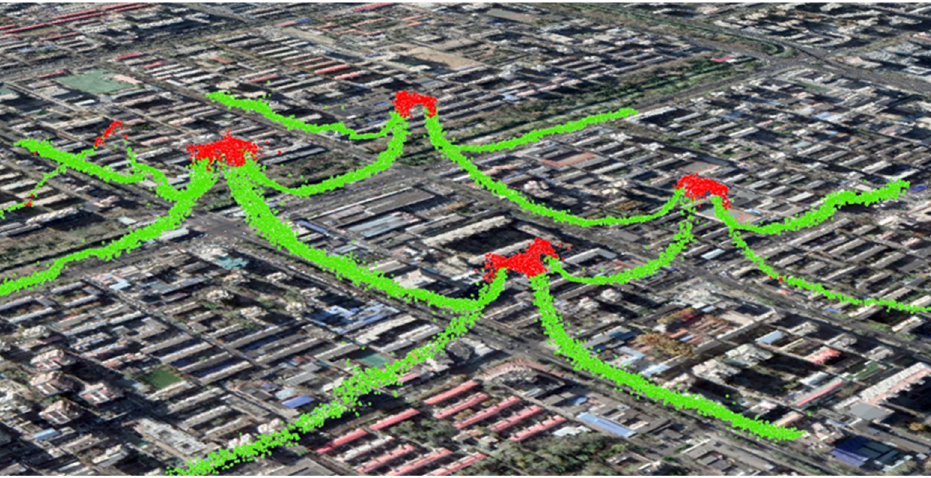
Figure 8. Three-dimensional map of the information entropy values for the tracking points in the Mudanyuan area, where red represents the on-crossroad points and green is the on-road points. We interactively selected 11,368 sample tracking points at the inner side of the Second Ring Road of Beijing, among which 8556 are on the streets and 2812 are at intersections. Based on Equation (1), the information entropies were computed for all samples. In a handout test, these samples were divided into two folders, with one folder containing 9094 samples to train the logistic regression model and the other consisting of 2274 samples for